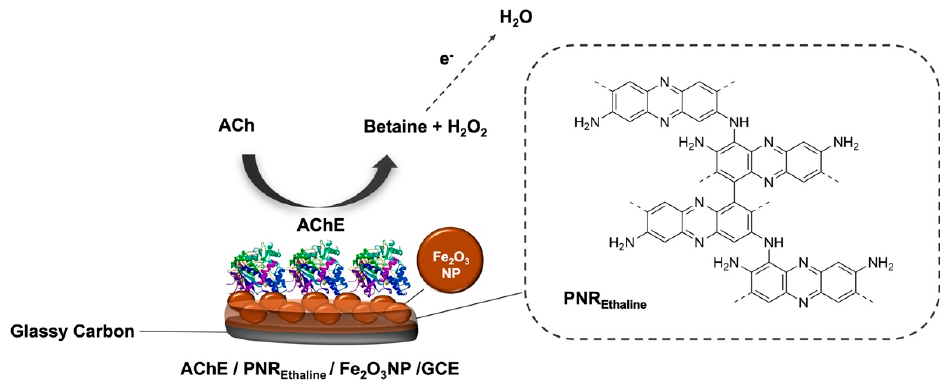
Figure 7. Schematic representation of the biosensor for acetylcholine detection. The glassy carbon electrode was modified with Fe2O3 nanoparticles; then the electropolymerization of neutral red in ethaline solution was performed, followed by immobilization of acetylcholinesterase (AChE).